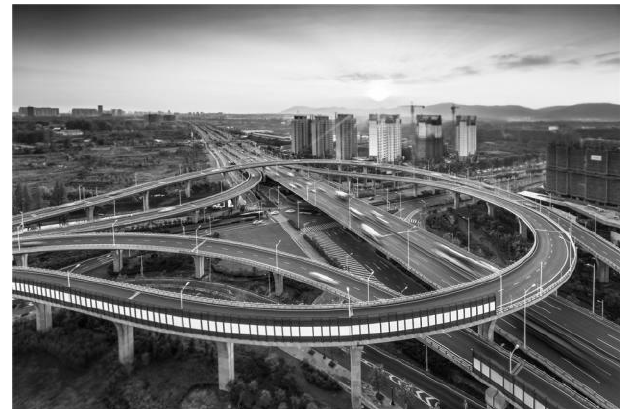
Figure 4 Three-dimensional traffic in Jiangbei New District